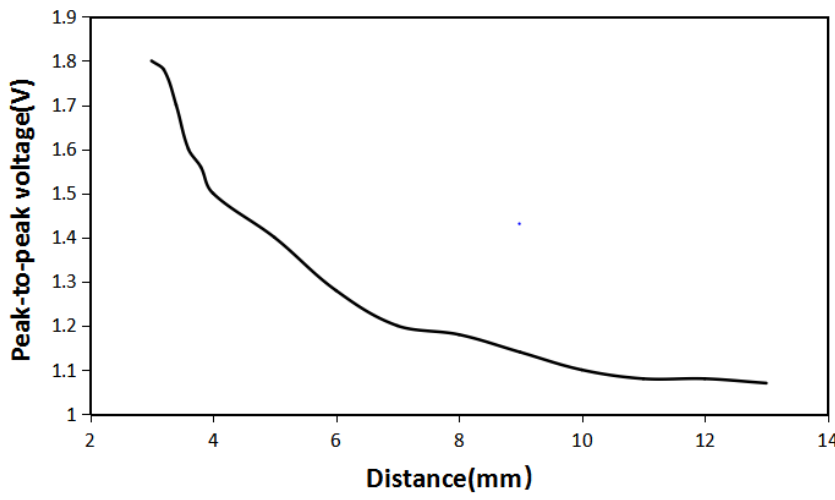
Figure 11. The maximum energy harvesting voltage of iron sheet and the Halbach array at different distance.